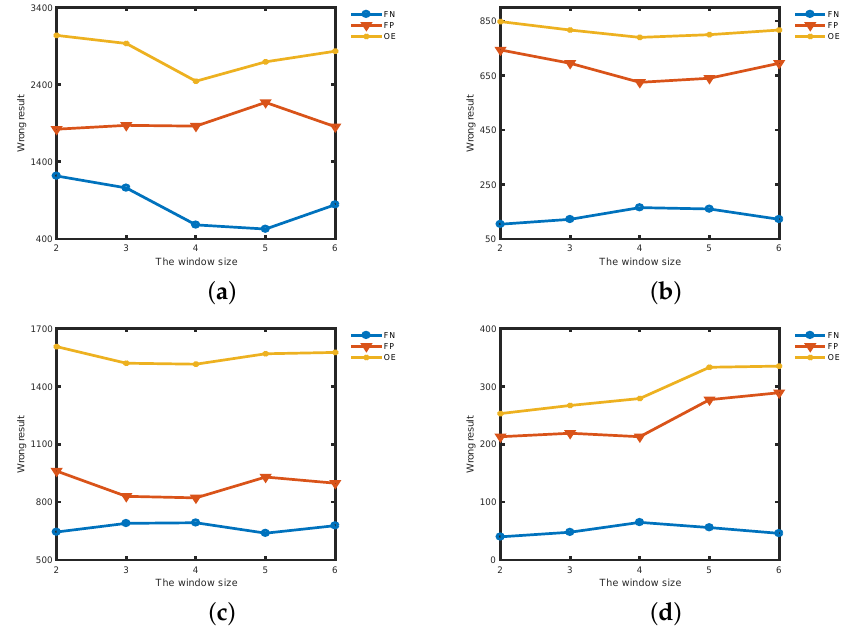
Figure 20. The wrong results on the window size in the non-local mean algorithm of four types of data. ( a ) Farmland D data set. ( b ) Farmland C data set. ( c ) Inland water data set. ( d ) Coastline data